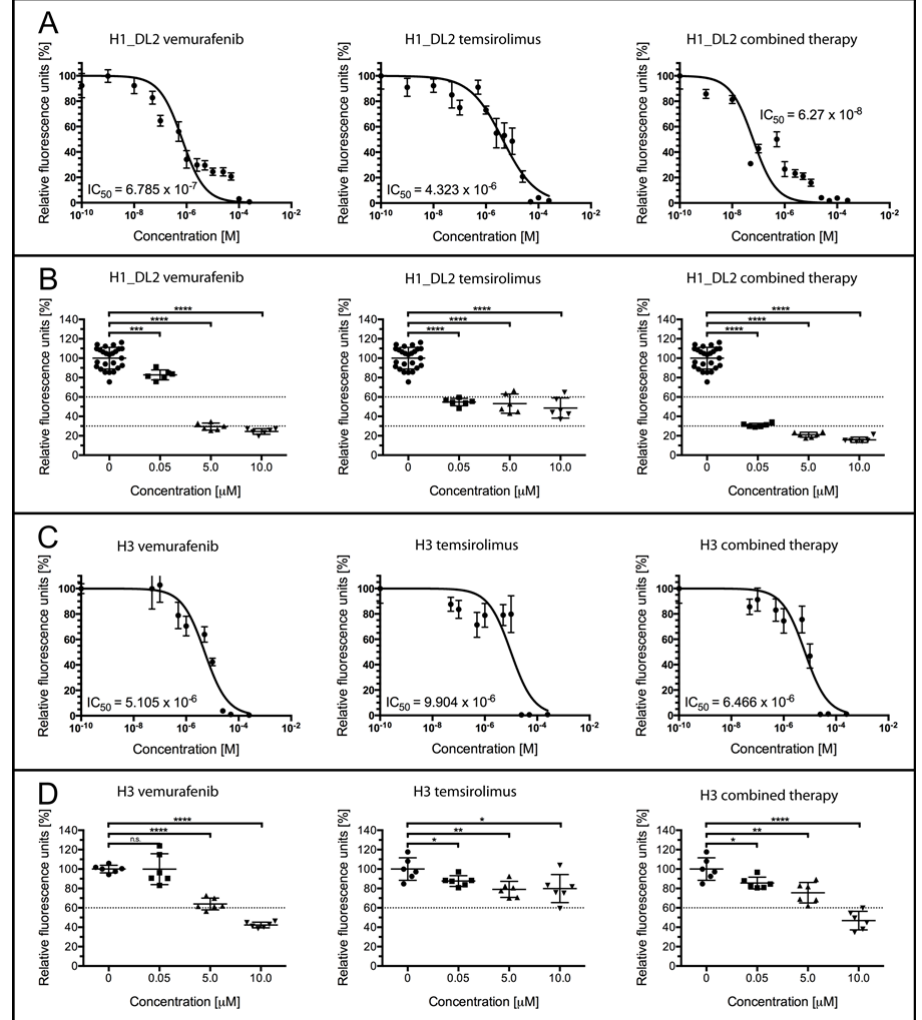
cell line had a homozygous deletion of PTEN on chromosome 10 (Figure S1B,C, red arrows). This indicates that both the MAPK and the PI3K pathways may be activated in these cells. Figure 1. Cell proliferation and survival of H1_DL2 and H3 melanoma brain metastasis cells grown as monolayer cultures, after treatment with vemurafenib and temsirolimus. ( A , B ) Treatment of H1_DL2 melanoma cells, harboring the BRAF V600E mutation. ( A ) H1_DL2 cells treated with increasing drug concentrations for 72 h ( n = 6, mean ± SD); ( B ) A more detailed analysis of the cell survival shown in (A), after drug treatment with 0, 0.05, 5 or 10 µM of vemurafenib, temsirolimus or a combination therapy. Scatter dot plot ( n = 6, mean ± SD). *** p < 0.001; **** p < 0.0001; ( C , D ) Treatment of H3 melanoma cells, harboring wild-type (WT) BRAF. ( C ) H3 cells treated with increasing drug concentrations for 72 h ( n = 6, mean ± SD); and ( D ) A more detailed analysis of the cell survival shown in ( C ), after drug treatment with 0, 0.05, 5 or 10 µM vemurafenib, temsirolimus or combined therapy. Scatter dot plot ( n = 6, mean ± SD). n.s.: not significant; * p < 0.05; ** p < 0.01; **** p <